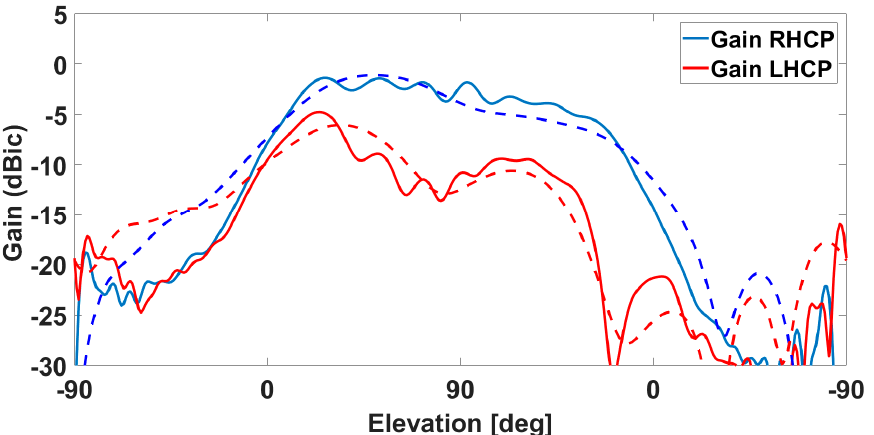
Figure 9. Pattern cut of the gain of one lateral antenna: ( blue ) RHCP; ( red ) LHCP. ( Solid Line ) on big ground plane; ( Dotted Line ) on small ground plane. Ripples in the solid lines are due to reflection from the ground plane itself.